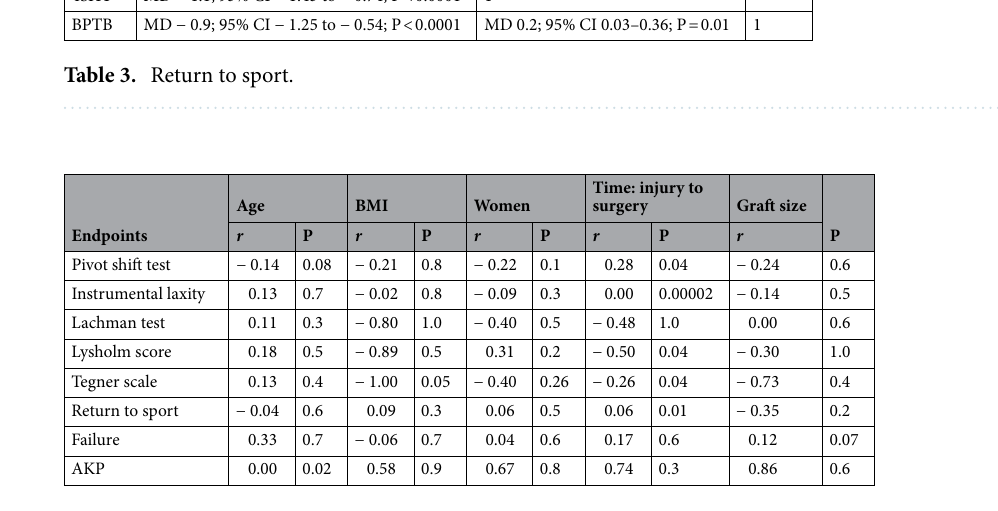
Table 4. Results of the multivariate analysis (AKP = Anterior knee